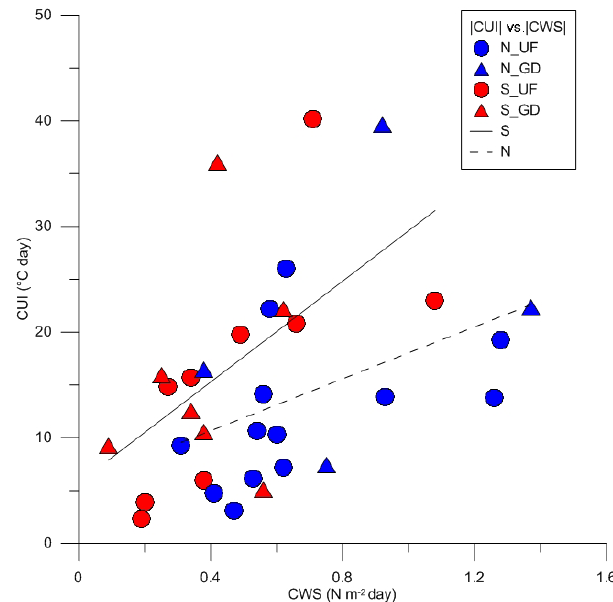
Figure 6. The relationship between the cumulative upwelling in- dex (CUI) and cumulative along-gulf wind stress (CWS) based on 33 detected upwelling events in May–September 2007–2013. Red symbols indicate the events off the southern coast and blue symbols the events off the northern coast; circles correspond to the events with a pronounced upwelling front (N_UF and C_UF) and triangles the events with a gradual decrease in temperature towards the coast (N_GD and S_GD). The linear regression lines for southern (solid line) and northern upwelling events (dashed line) are